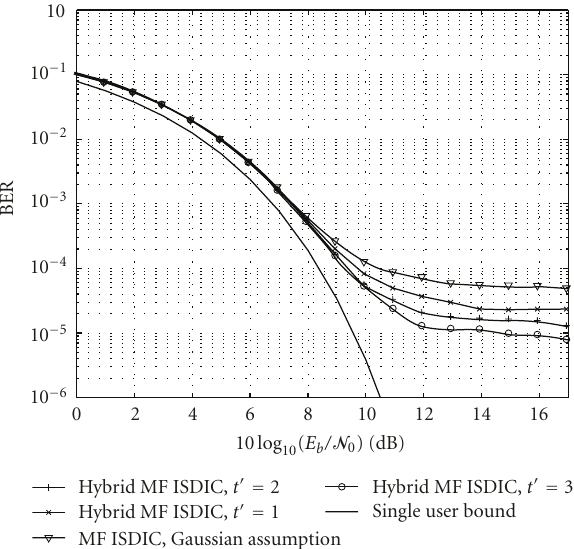
Figure 7: BER versus E b / N 0 for MF ISDIC employing the Gaussian assumption and hybrid MF ISDIC. μ max = 40, (cid:2) = 0 . 05, 4QAM with = 2, uncoded DS-CDMA downlink transmission with K = 10 σ 2 a spreading sequences having spreading factor N = 16 over a Rayleigh multipath channel, ideal power